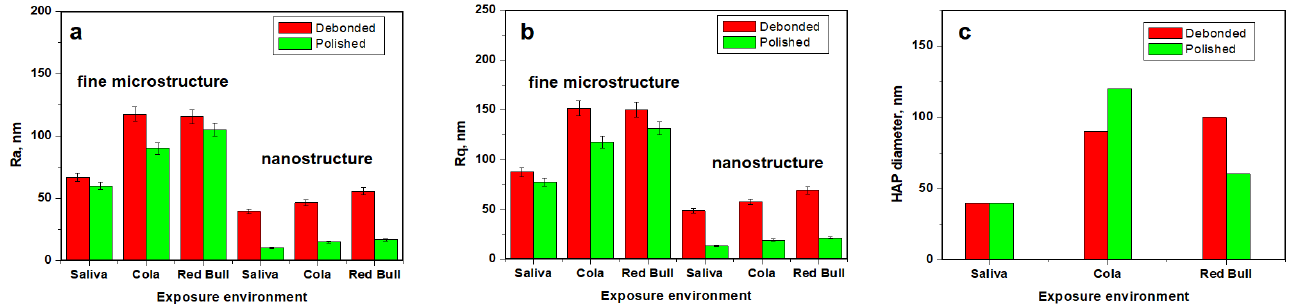
Figure 4. The evolution of the parameters measured with AFM for CR samples: ( a ) Ra, ( b ) Rq, and ( c ) nano HAP diameter.